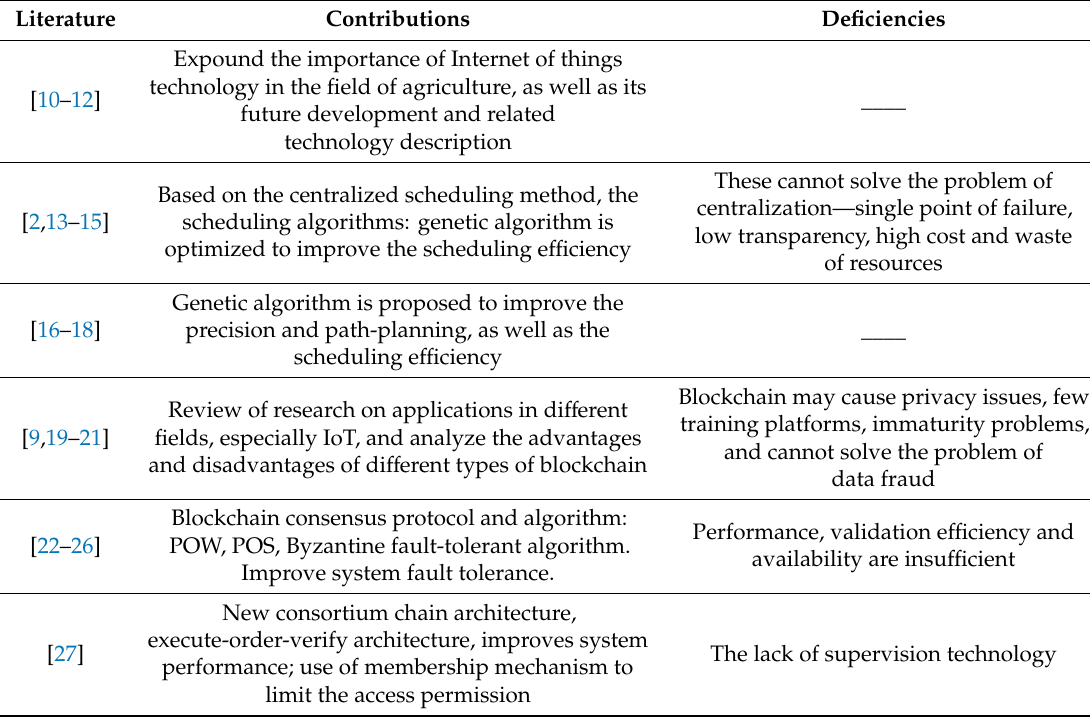
Table 1. Contributions and Deficiencies of Related